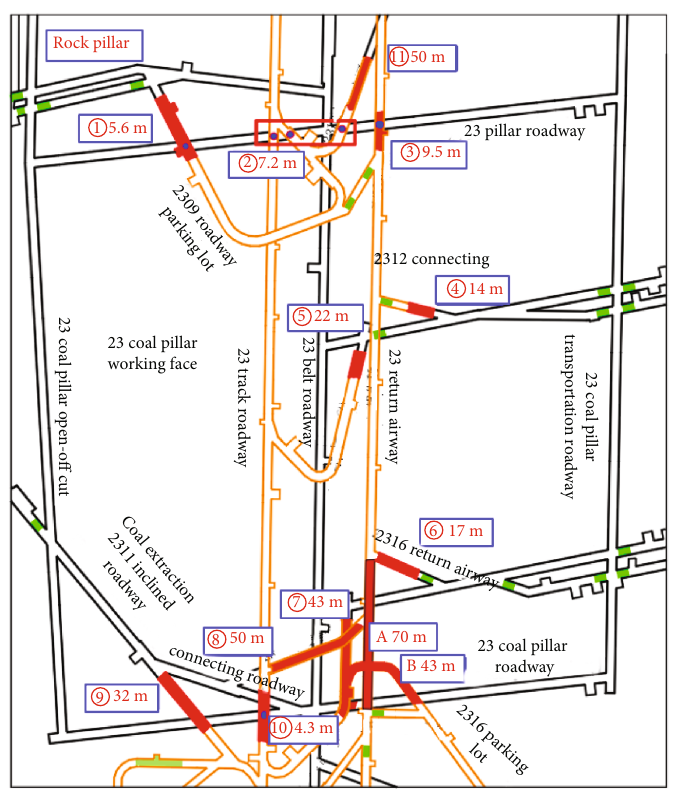
Figure 11: Positions requiring to be reinforced when the working face passes through the roof abandoned roadway.